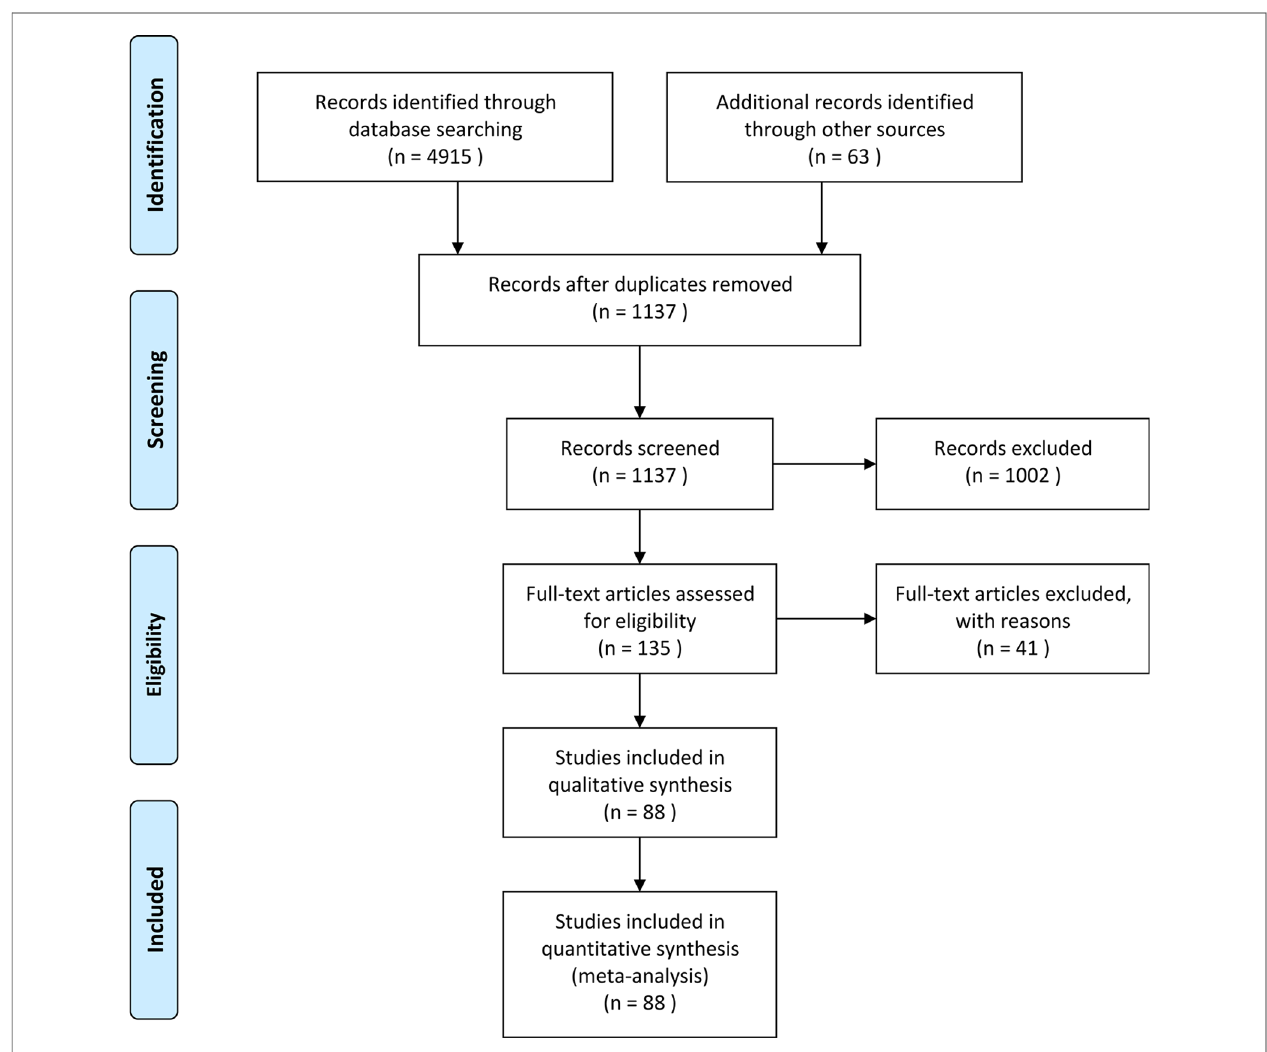
FIGURE 1 | PRISMA fl ow